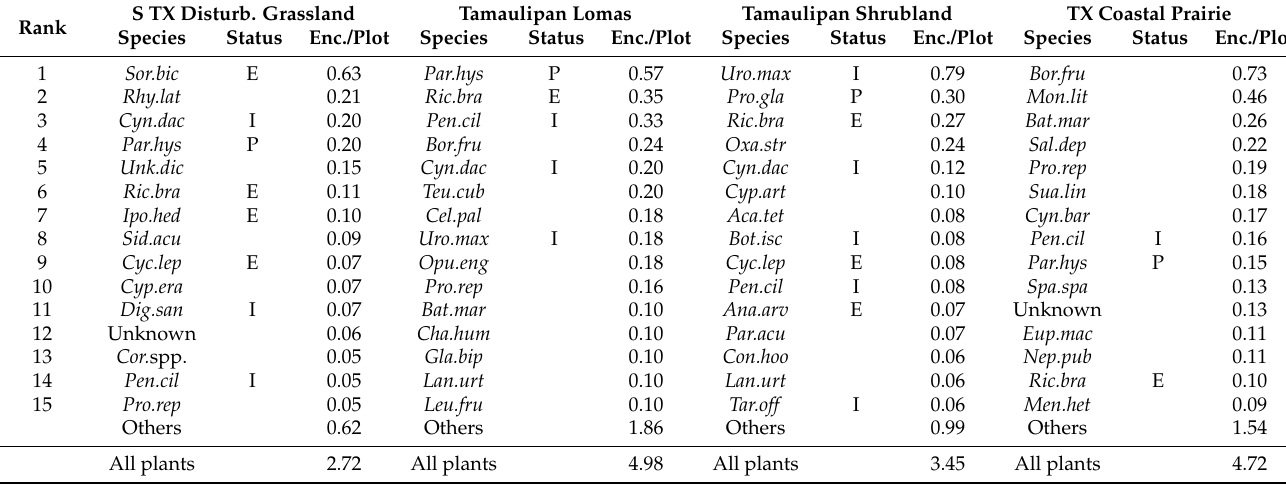
Table 1. Lists of the 15 most abundance plant species observed within the four focal habitat classes in the Lower Rio Grande Valley of south Texas, ordered by prevalence. Status indicates whether a species is a non-native exotic (E), considered a pest (P), or both exotic and a pest (an invasive species; I); blank values indicate a species is native to the region and not considered a pest. Survey effort varied among habitat classes, so prevalence was normalized and quantified as the proportion of plots where a plant species was encountered (# plots where encountered/total plots). Full species names and taxonomic information corresponding to the species codes shown here are found in Table S1 (the full plant species list). Legend: enc., encounters; spp.,